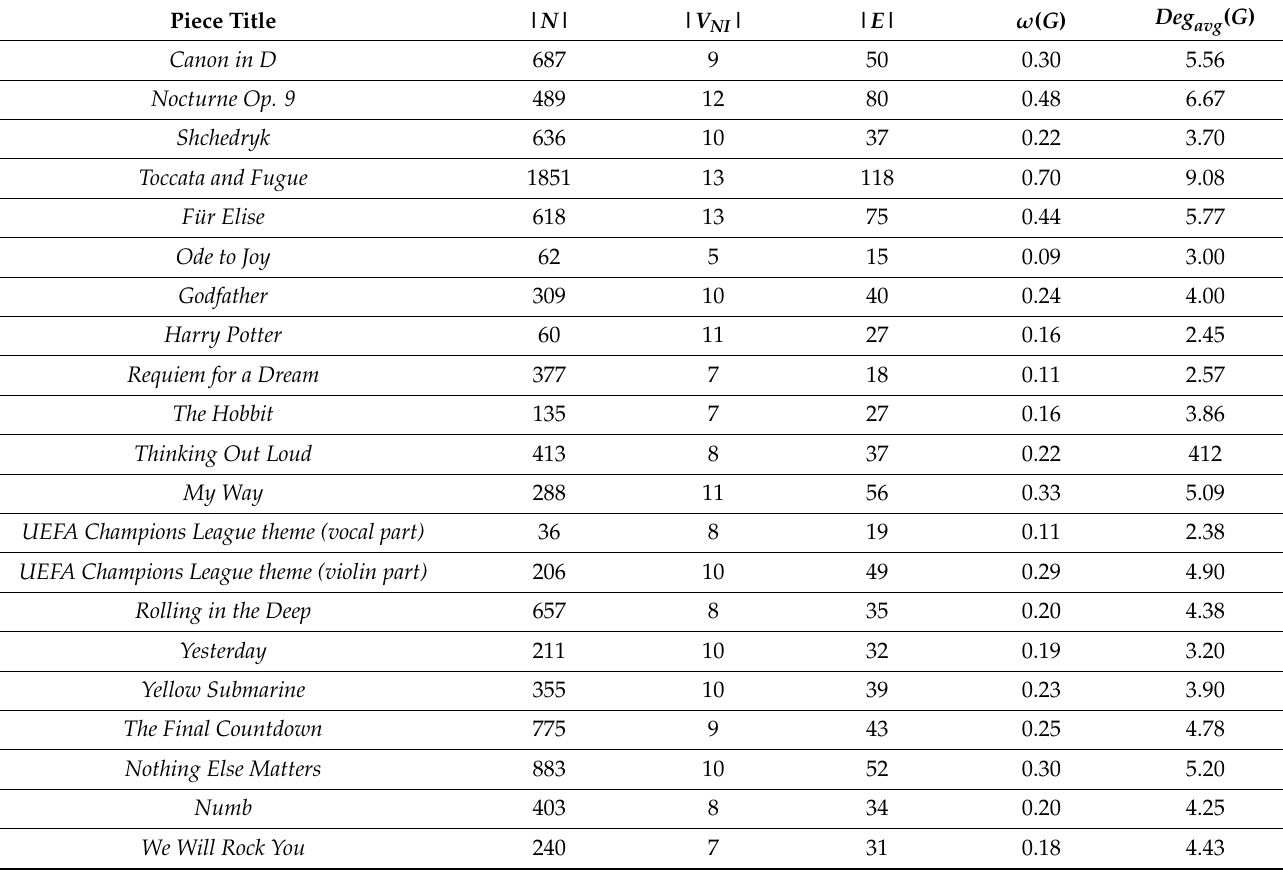
Table 1. Graph characteristics of the compared pieces.